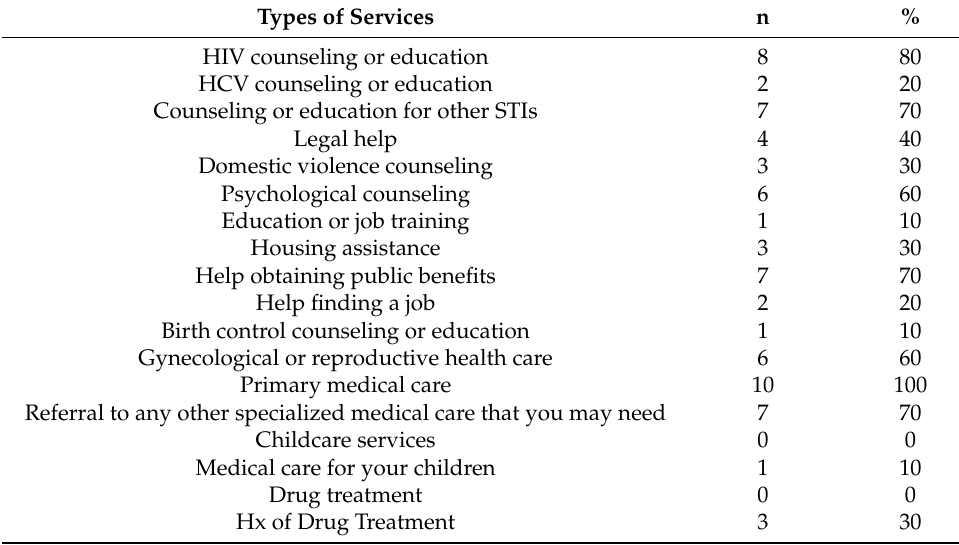
Table 6. Service utilization over the past 3 months (N =